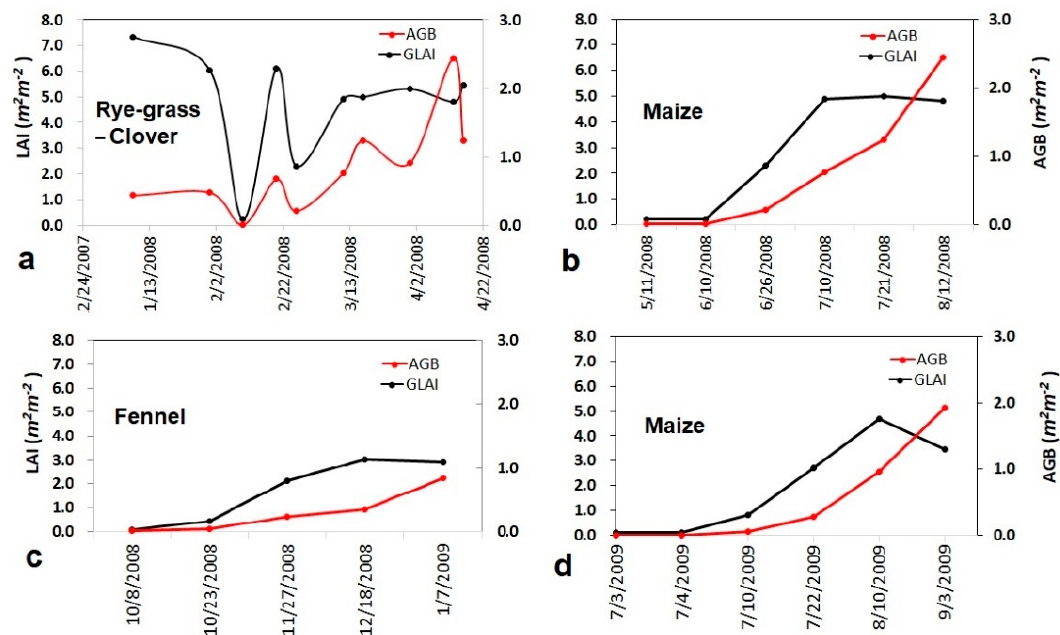
Figure 4. Measured leaf area index (LAI) and above ground biomass (AGB) for ( a ) rye-grass–clover 2008, ( b ) maize 2008, ( c ) fennel 2008–2009, ( d ) maize 2009 throughout each crop growing season on y -axis, the measurement dates are provided along the x-axis .